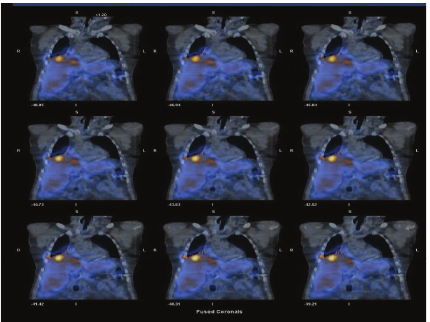
Figure 2: Bronchoscopic images of right main stem bronchi show- ing multiple polypoid lesions, which on biopsy confirmed carcinoid.